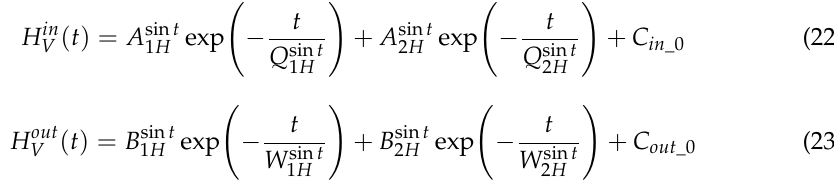
Figure 7. Elastic modulus of YSZ topcoat versus time during the first three cycles.